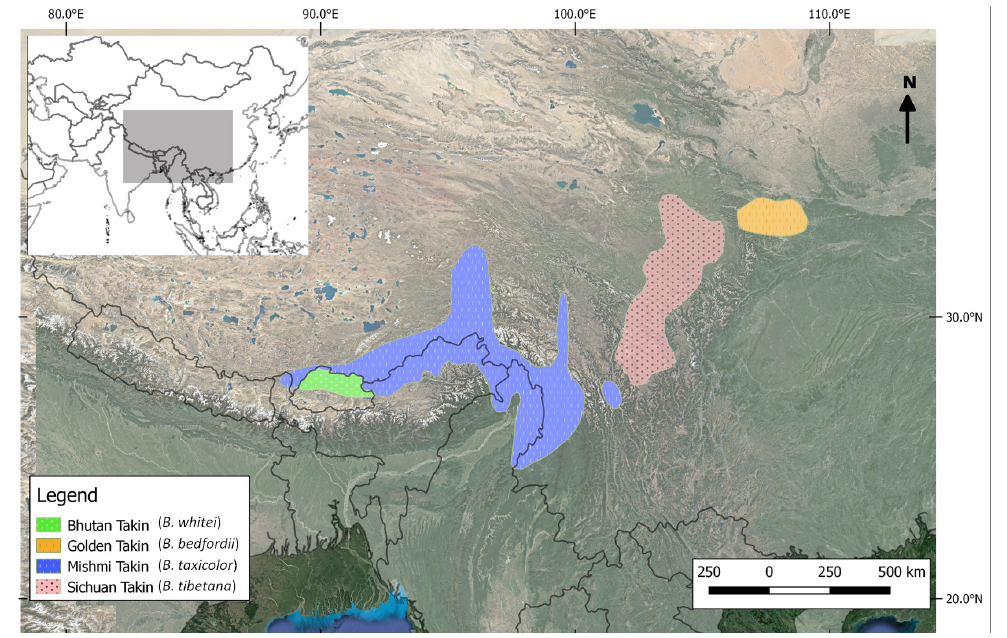
Figure 1. The current distribution of the four takin species in southern